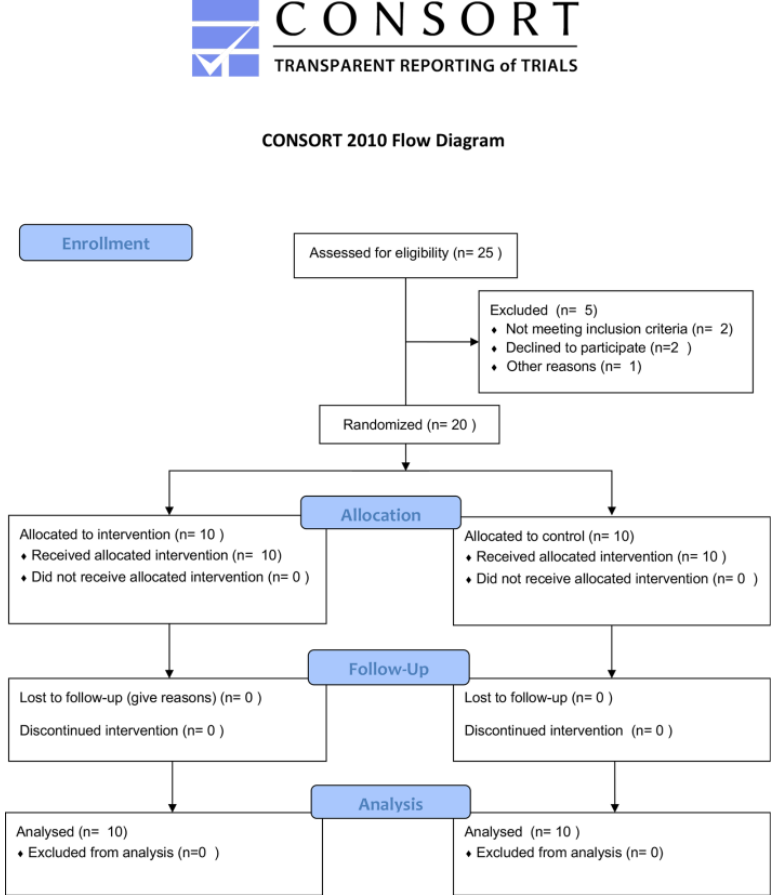
Figure 2. Flow diagram of the progress through the study phases according to the CONSORT 2010 statement.